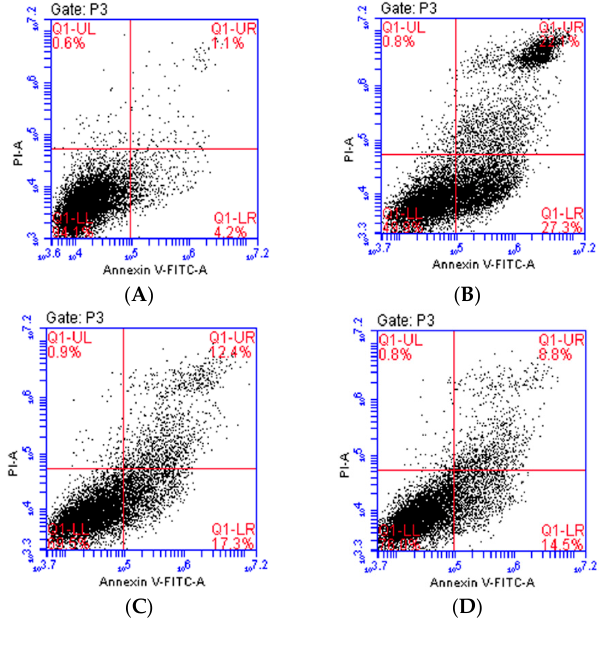
Figure 2. Hoechst 33342 and PI staining in EA.hy926 cells. ( a ) Representative fluorescence